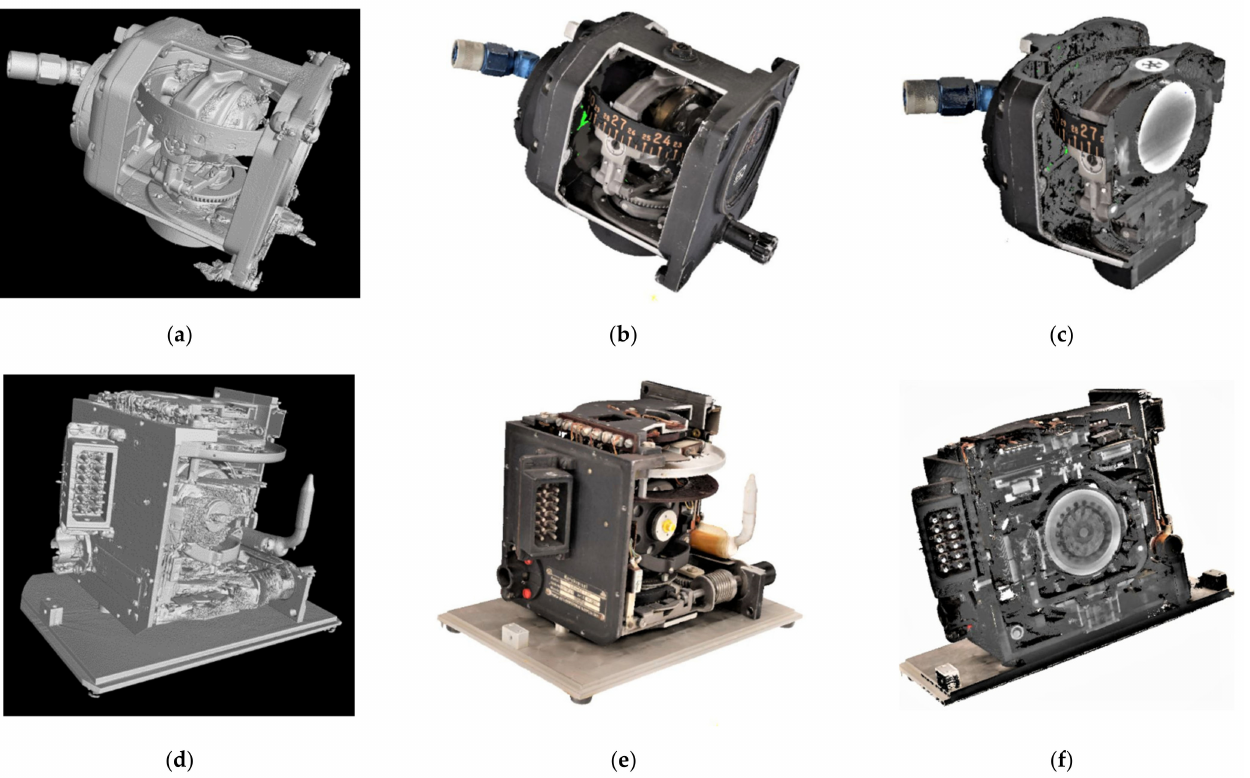
Figure 29. Two more 3D digital twins of the Stuttgart gyroscope collection—the Ternstedt direction gyro ( a – c ), and the Siemens direction gyro ( d – f ): ( a , d ) iso-surfaces of the denoised FBP CT scans; ( b , e ) meshed point clouds of CV/photogrammetry; and ( c , f ) split views of the CT/CV integrated